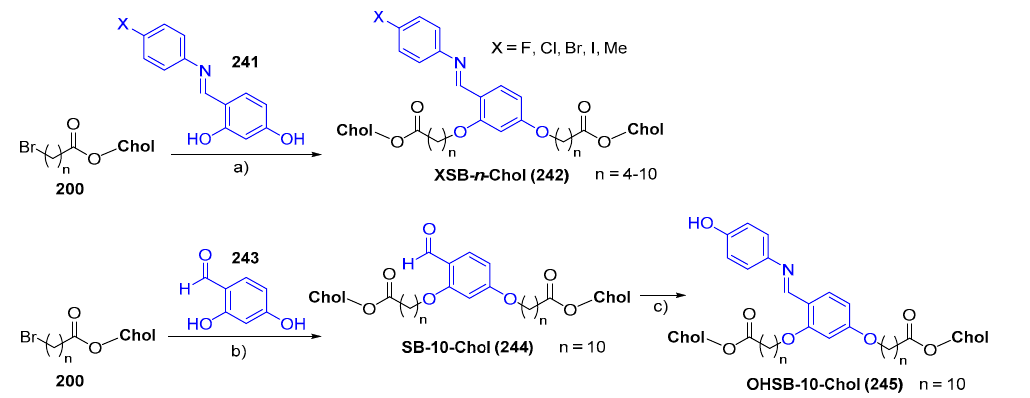
Scheme 60. Synthesis of λ -shaped chiral liquid crystal trimers. Reagents and conditions: a ) K 2 CO 3 ,